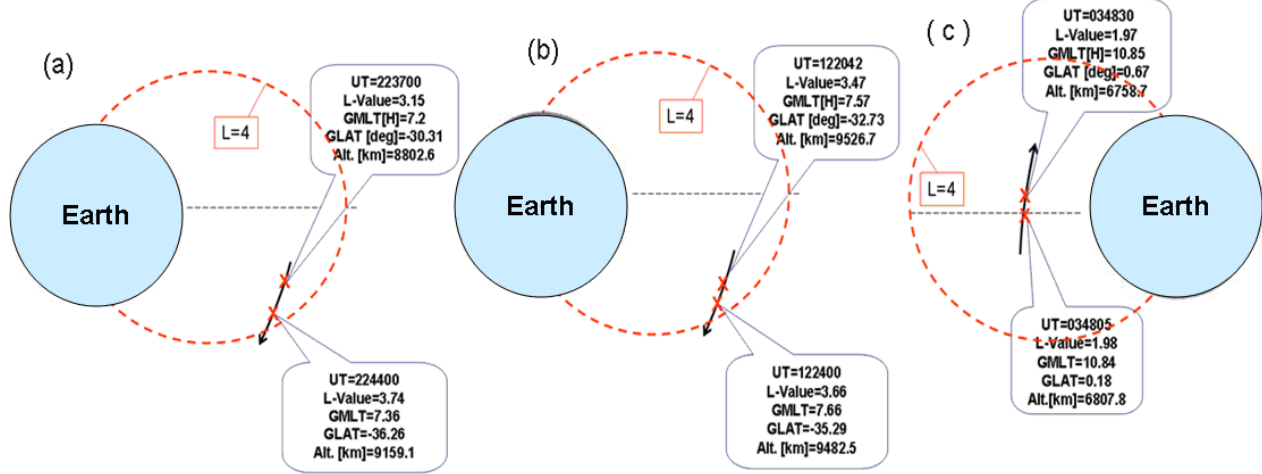
Fig. 2. Schematic illustration of satellite path for three Events 1, 2 and 3, respectively.